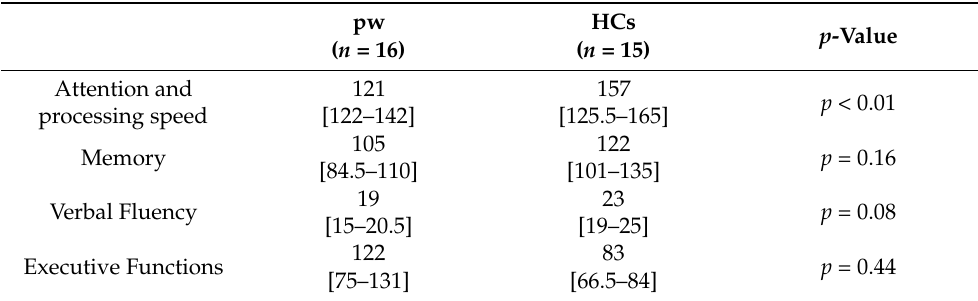
Table 3. Differences in global cognitive domain scores between Multiple Sclerosis patients (pwMS) and healthy controls